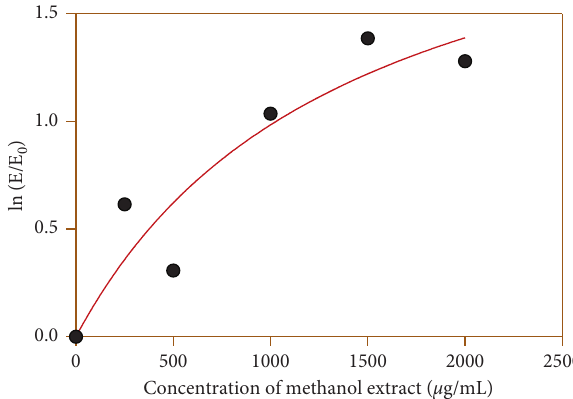
Figure 5: A plot of the natural logarithm of the percentage remaining activity of α -glucosidase against the pre-incubation times at different concentrations of the methanol extract con- centration from P. americana